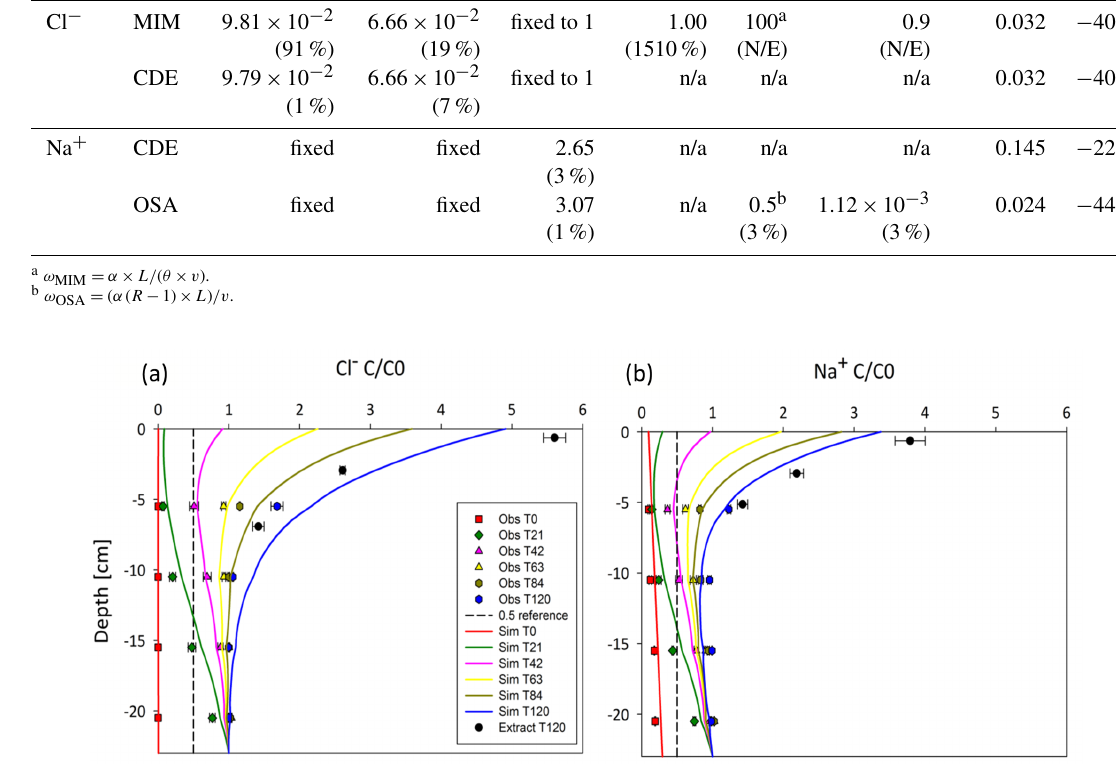
Figure 7. Observed values (Obs) from the unsaturated column experiment vs. simulated values (Sim) of (a) Cl − and (b) Na + . Observed values are averages and standard error; n = 3. T stands for time, and the number that follows is the number of days. Extract T120 represents values measured via extraction as part of post-experiment processing. Depth of 0cm marks the top of the column. The dashed reference line marks C/C 0 = 0 .